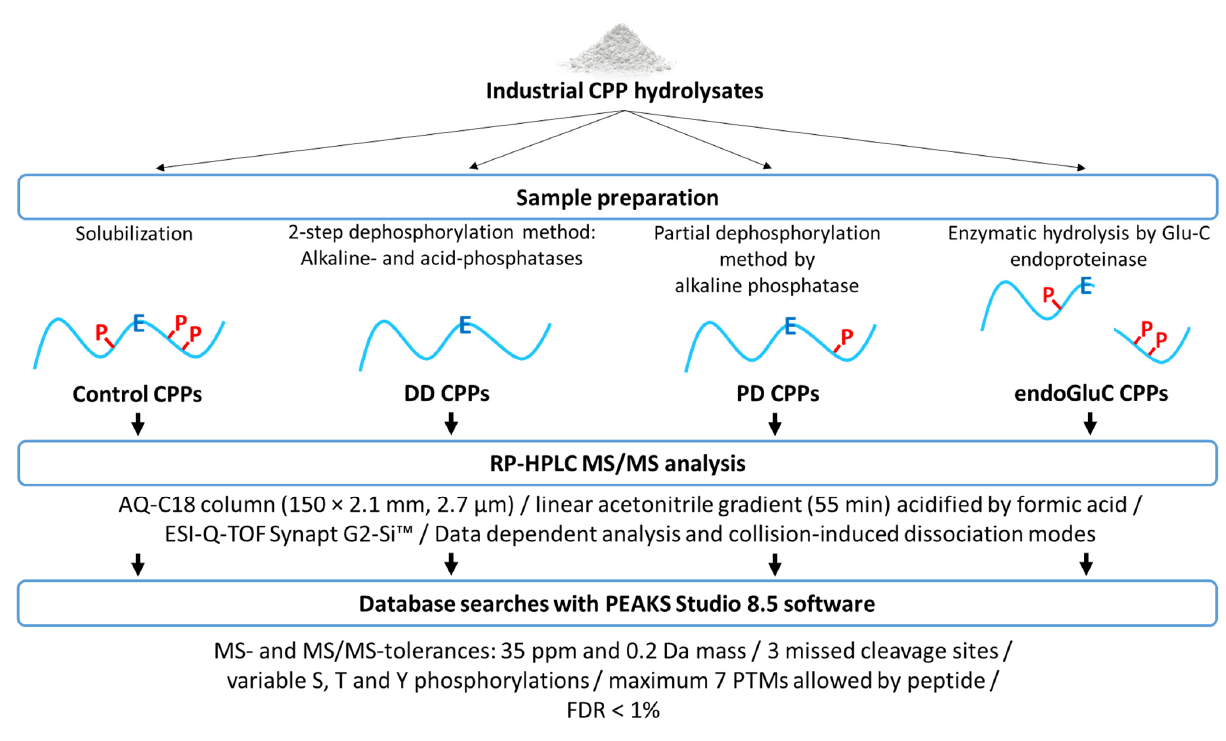
Figure 1. Schematic representation of the four-phase strategy to detect a maximum of CPPs, including multiphosphorylated and large-size CPPs, using RP-HPLC, high-resolution mass spectrometry (MS) and bioinformatics. Control—for no treatment; DD—for double-dephosphorylation; PD—for partial dephosphorylation; and endoGluC-CPPs—for endoGluC hydrolysis of CPP hydrolysates. PTMs, post-translational modifications; P, phosphosites; E, glutamic acid.